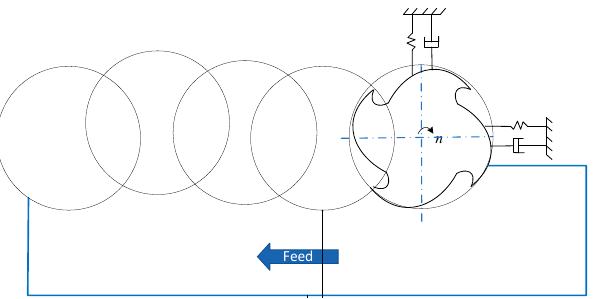
Figure 5. Surface topography considering dynamic characteristics of the milling system.